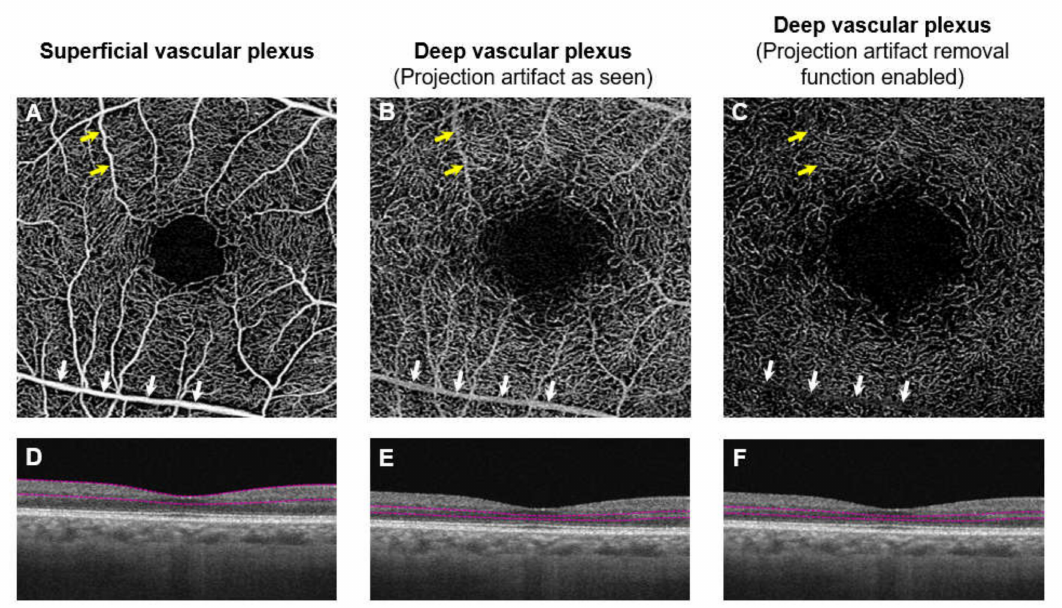
Figure 10. Angiographic images and projection artifacts. ( A – C ) are di ff erent en face capillary plexus and ( D – F ) are their corresponding B-scan images of the same eye. The superficial capillary plexus is shown in A and deep capillary plexus is shown in ( B , C ). When the segmentation section is lowered to include the region around the inner nuclear layer and outer plexiform layer, the deep capillary plexus should be seen. However, the vascular pattern seems similar to the superficial capillary plexus. Note the superficial vessels seen in the angiographic image (yellow and white arrows; ( A , B ). The superficial vessels are seen because of a projection image. When the projection removal algorithm is enabled, it removes most of the projection image from the superficial capillary plexus. Although smaller superficial vessels are no longer visible (yellow arrows); ( C ) larger superficial vessels still persist (white arrows; C